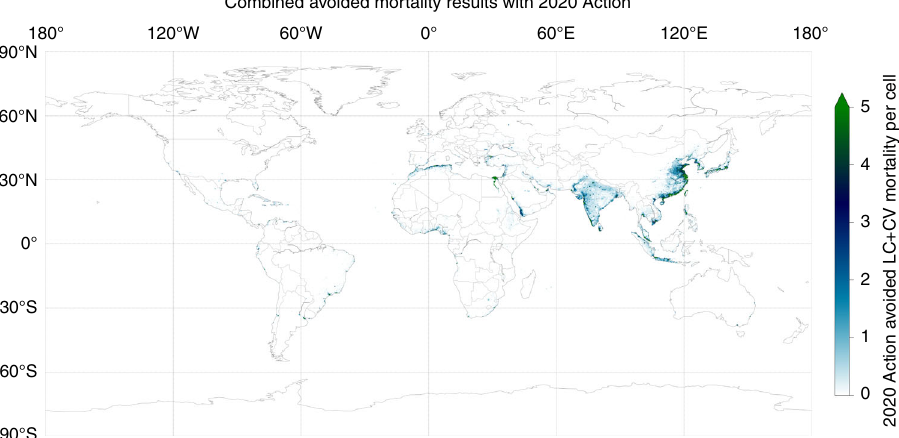
Fig. 4 Avoided mortality due to fuel sulphur standards. Map of avoided mortality (cardiovascular disease and lung cancer) from reduced ship PM 2.5 emissions due to implementation of the International Maritime Organization ’ s low-sulphur fuel standards in 2020. Annual avoided mortality minimum and maximum are 0 and 800,